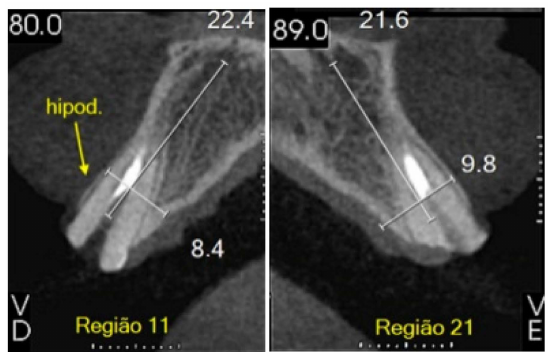
Figure 1. Initial